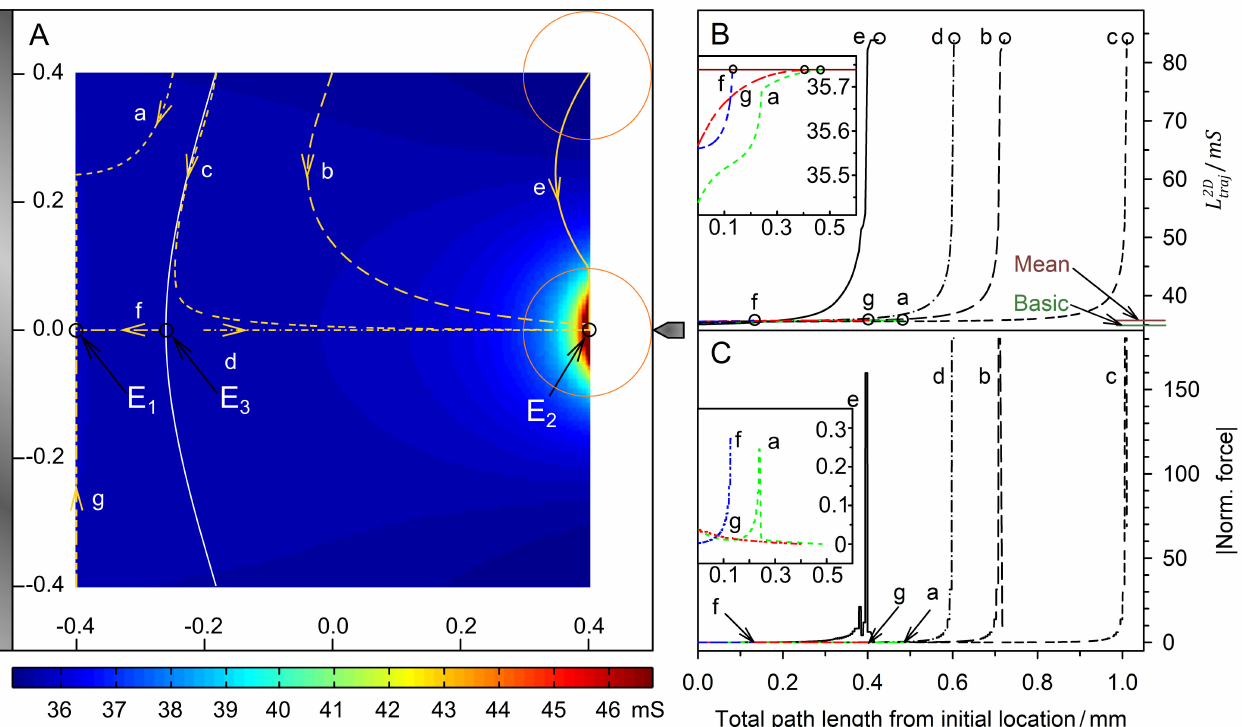
Figure 5. Single 200 µ m, 2D sphere of 1.0 S (reddish circles in ( A )) in the chamber of Figure 2 with 0.1 D = S medium. The mean conductance is L 2 35.739 mS. ( A ) Conductance field plot with trajectories (a–g). A watershed (bent white line) separates the two caption areas of the stable endpoints E 1 and E 2 . E 3 is an instable saddle point in the middle of the watershed. ( B ) Sheet conductance along the trajectories. Basic and mean conductance are marked. The system’s sheet conductance increases steadily along each trajectory, reaching moderate and high peak values at the endpoints E 2 and E 1 , D respectively. Trajectories b, c, d, and e end at E 2 . Trajectories a, f, and g end at E 1 , reaching L 2 by coincidence (insert). ( C ) Normalized DEP forces calculated with Equation (16) from the conductance values in ( B